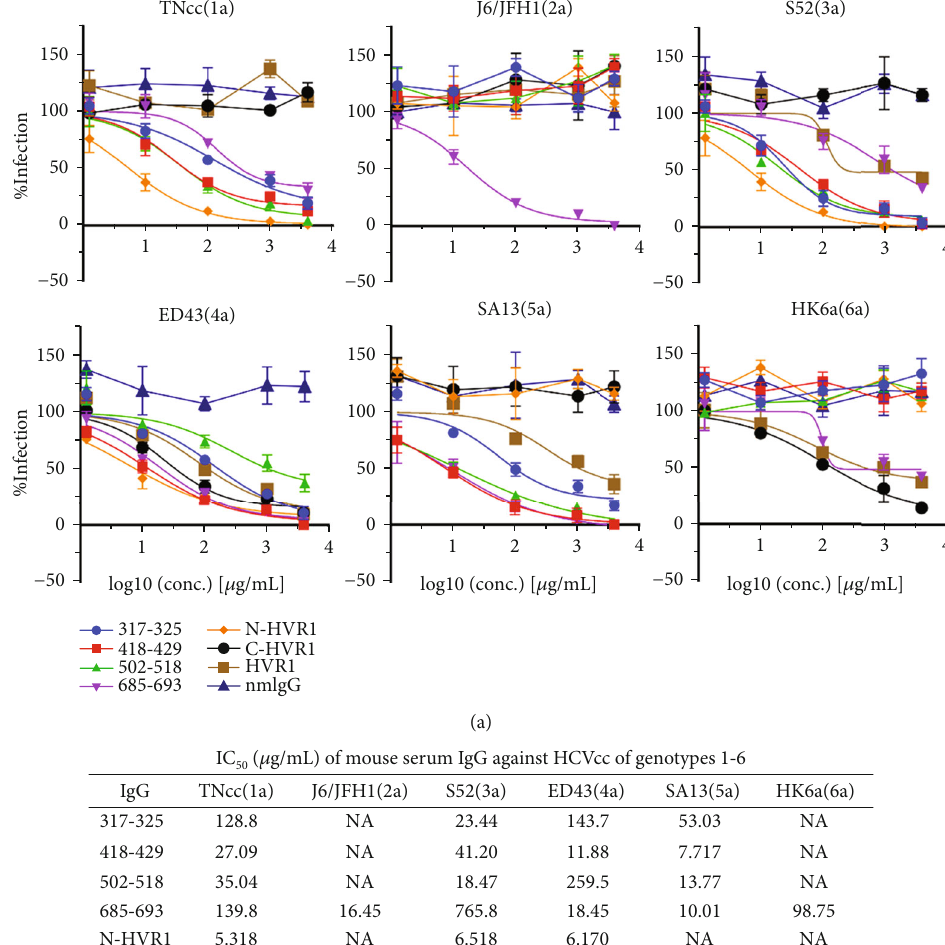
Figure 4: IC of mouse IgG. (a) Mouse IgG was serially diluted at 4000, 1000, 100, 10, and 1 μ g/mL, and neutralization activity was evaluated 50 by a neutralization assay. Each experiment was performed in duplicate, and the mean ± SEM is shown. (b) The concentration of IgG inhibiting 50% of HCVcc infection was de fi ned as the half-maximal inhibitory concentration (IC method with GraphPad Prism 8